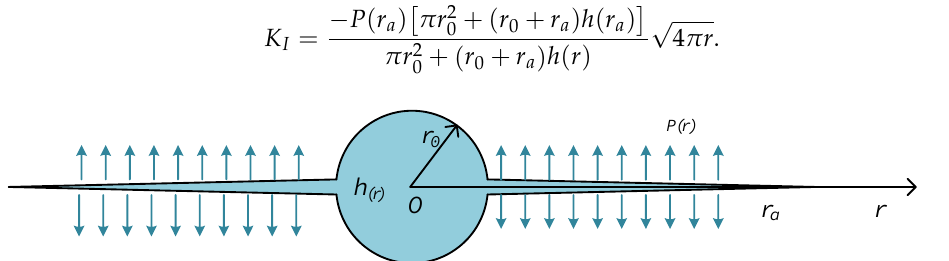
Figure 11. Dynamic propagation model of planar wedge cracks in infinite rock mass.